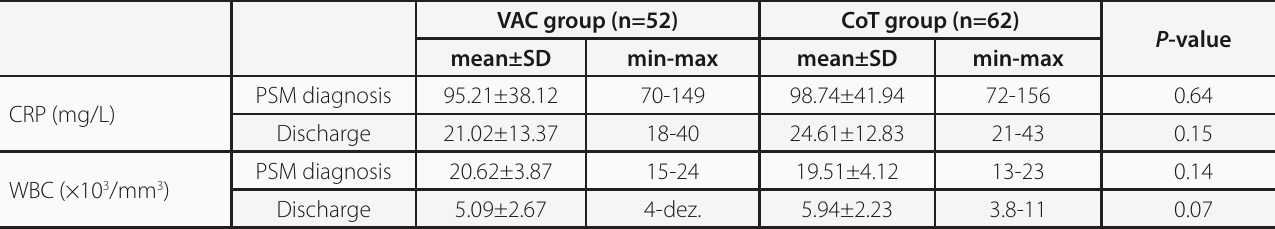
Table 3. C-reactive protein (CRP) level and white blood cell (WBC) count for both groups measured at the time of post-sternotomy mediastinitis (PSM) diagnosis and